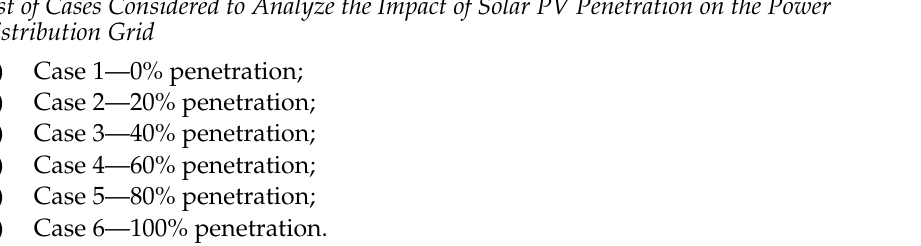
Figure 2. IEEE 33 node model along with Solar PV-DGs and